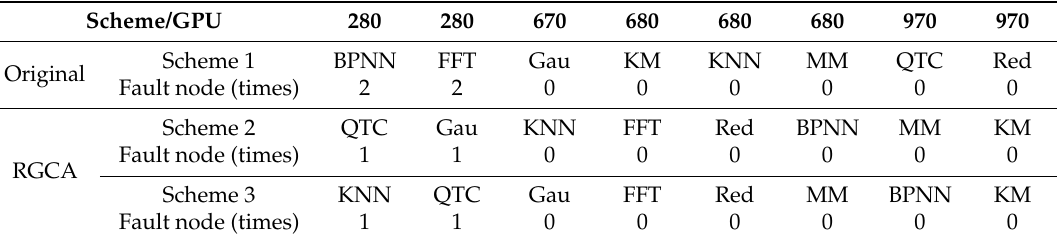
Table 8. Reliability contrasted against the baseline